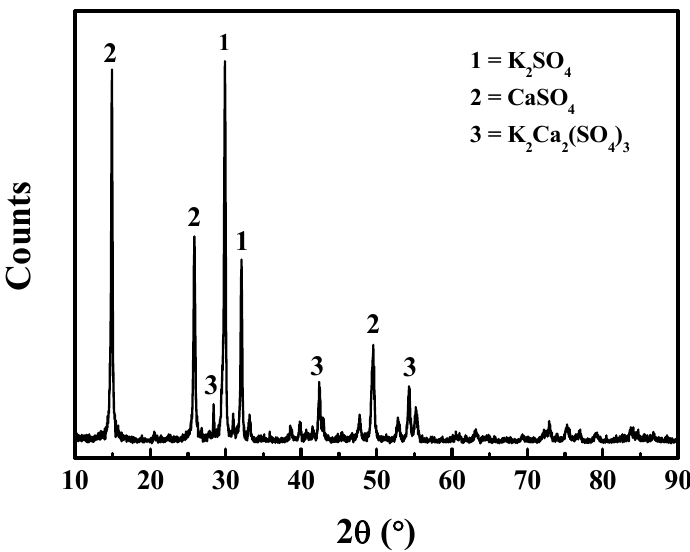
Figure 4. XRD patterns of the crystallized product of lixivium from the calcined products at 700 °C (CaO/alunite = 0.2). Table 1. X-ray fluorescence (XRF) analysis of the crystallized product of lixivium from the calcined products (CaO/alunite = 0.2) (in oxide form).